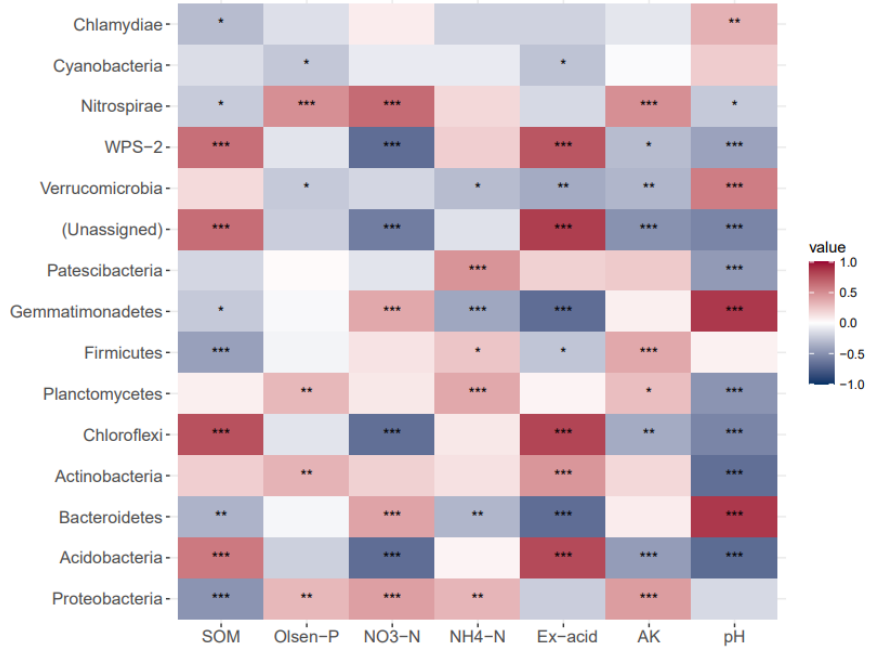
Figure 8. Correlation analysis between soil chemical properties and relative abundance of dominant bacterial phylum. * represents significance p < 0.05, ** represents significance p < 0.01, *** represents significance p < 0.001.